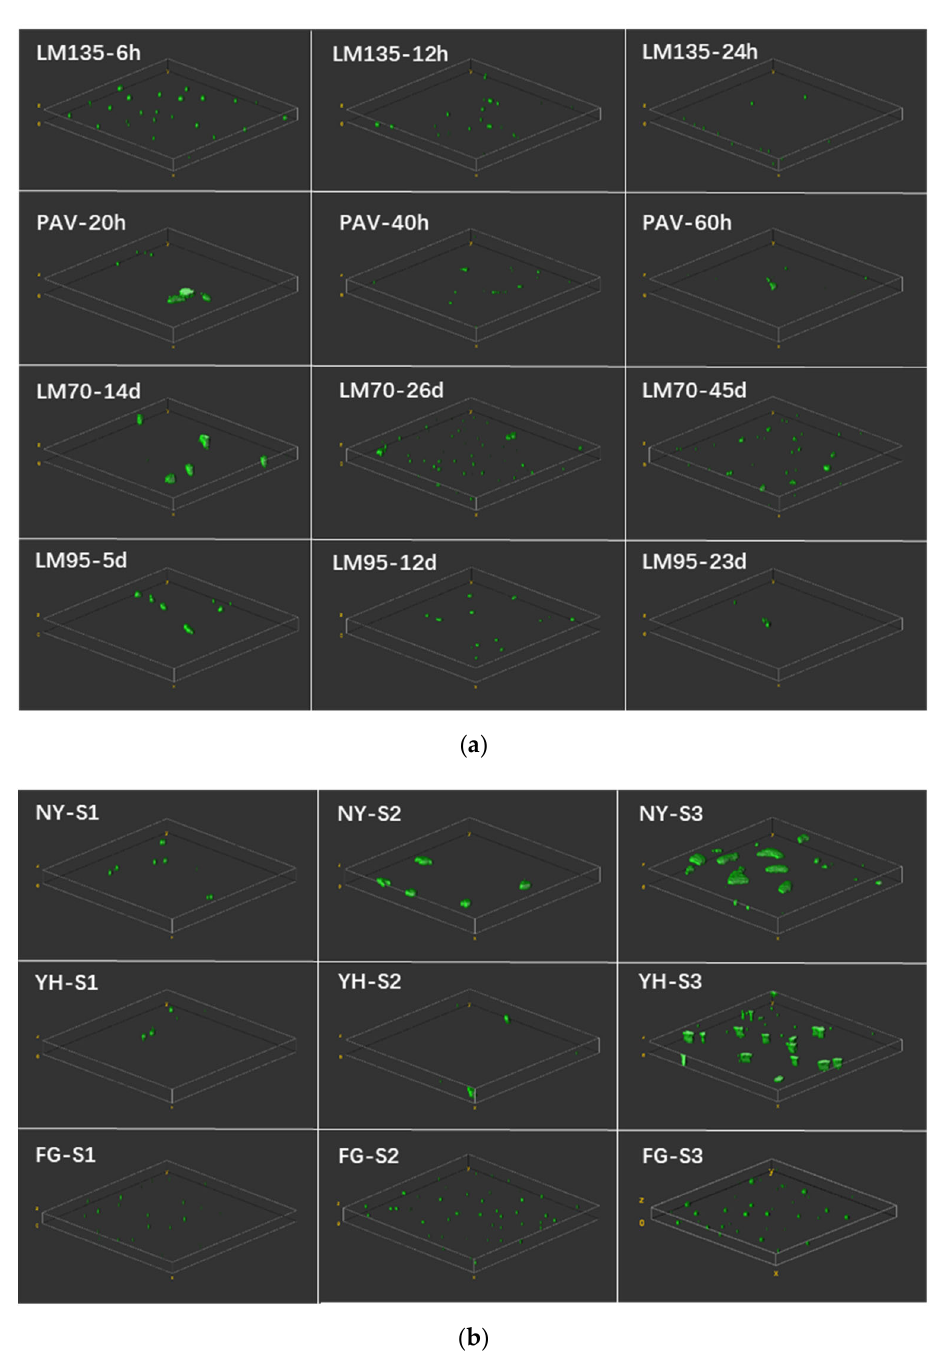
Figure 7. Three ‐ dimensional morphological maps of SBS polymer (100 × 100 × 5 μ m): ( a ) lab ‐ aged samples; ( b ) field ‐ aged samples. samples; ( b ) field-aged